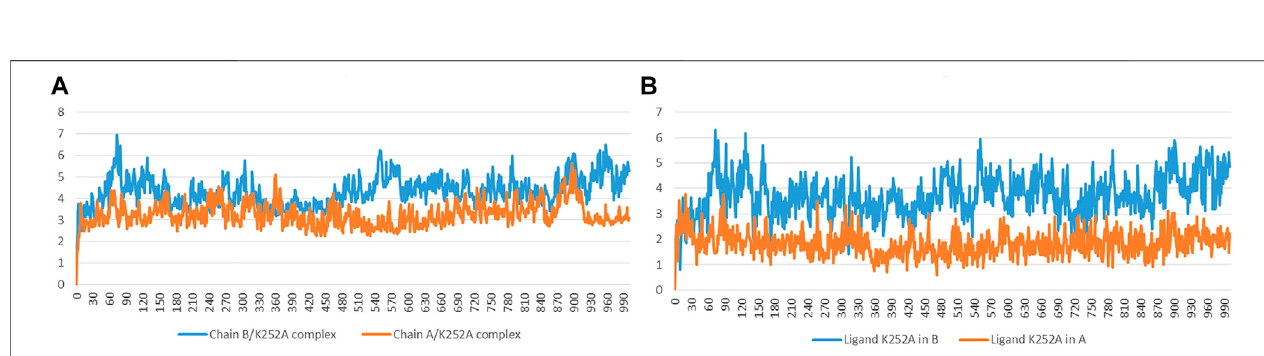
FIGURE 5 | Time evolution of the RMSD (Å) values of backbone atoms (A) and ligand K252a (B) in the active form (Chain B) and the inactive form (Chain A).